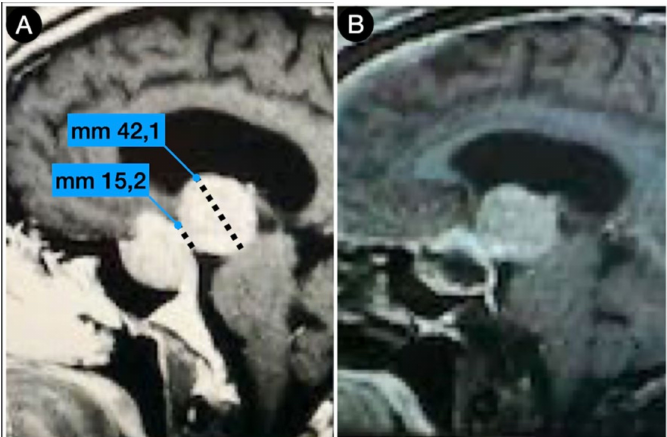
Figure 4. Preoperative ( A ) and postoperative ( B ) (post-trans-sphenoidal approach) sagittal T1- weighted contrast-enhanced MRI.